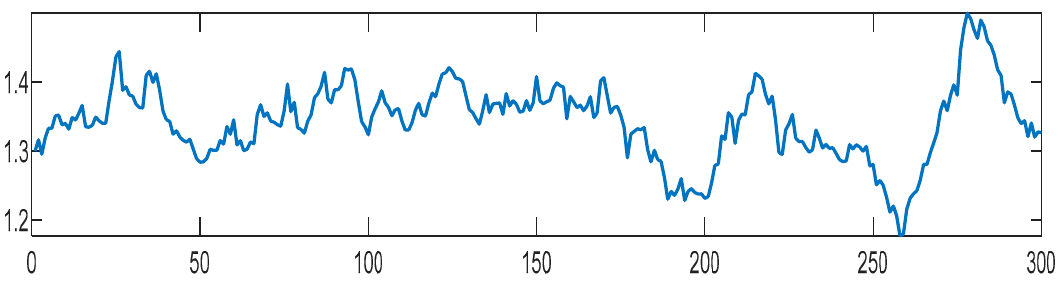
Figure 11. Selected constant mean value scenario of gas prices.